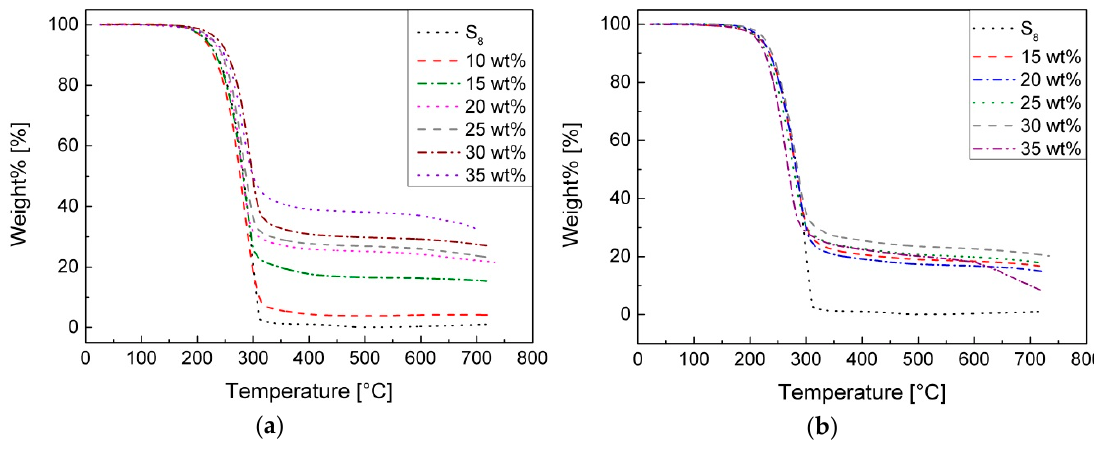
Figure 5. TGA-thermograms with varying incorporated monomer content: ( a ) pS-DVB; ( b ) pS-DIB.